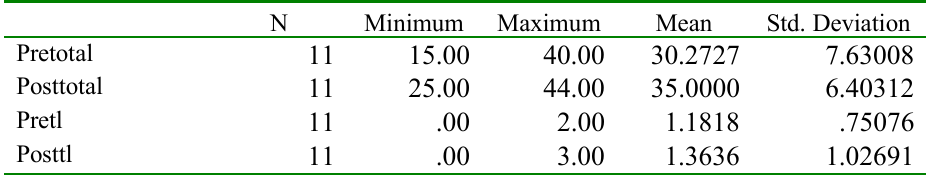
Descriptive Statistics for Group A (+IE,